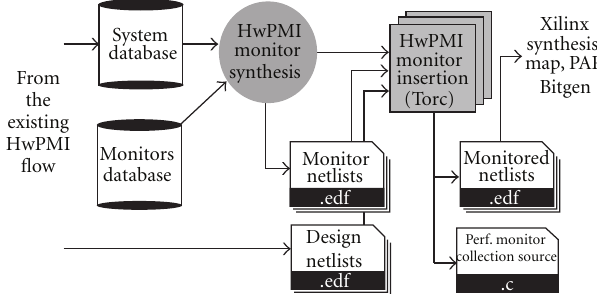
Figure 9: Insertion of Torc into Hardware Performance Monitoring Infrastructure’s Tool